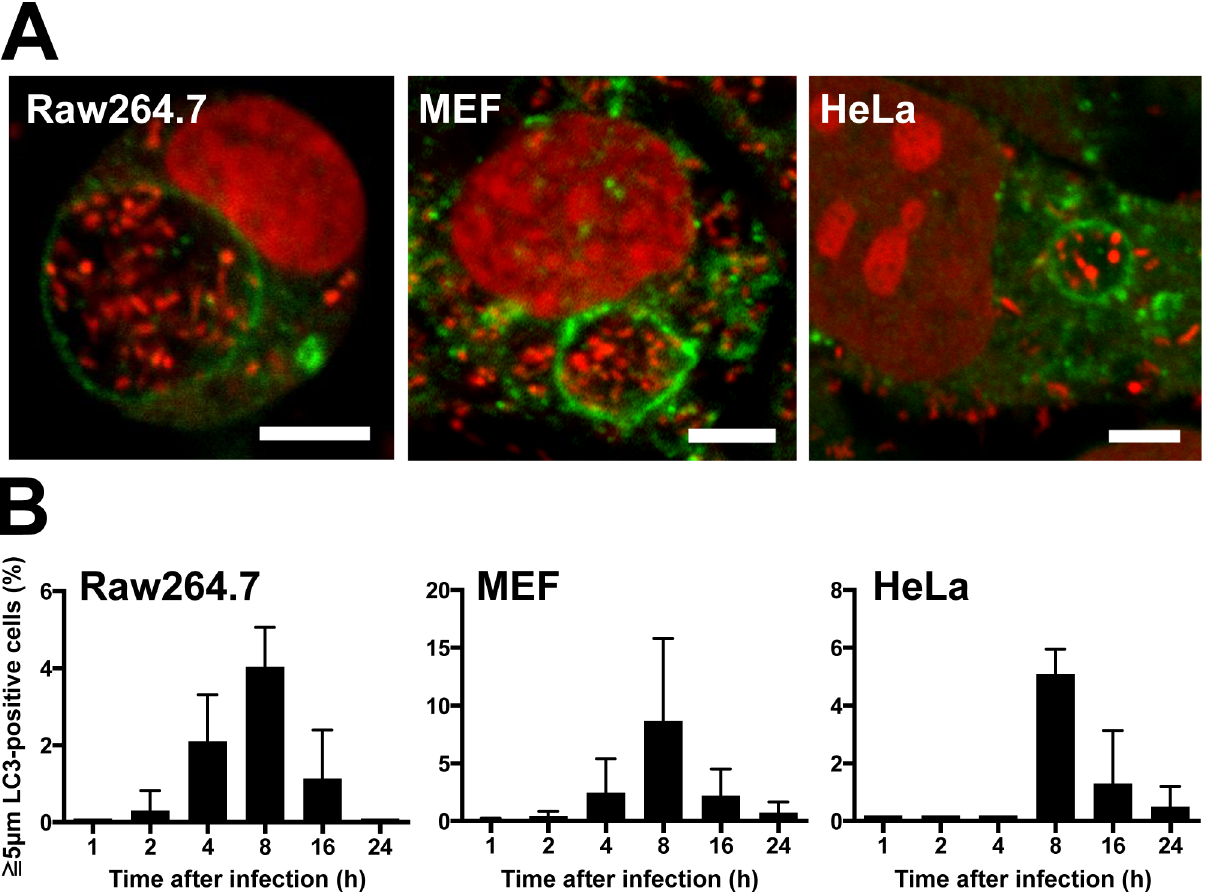
Fig 2. Large LC3-positive vacuoles containing many P . acnes . (A) Confocal microscopic image of large ( (cid:1) 5 μ m in diameter) LC3-positive vacuoles containing many P . acnes found in Raw264.7, MEF, and HeLa cells at 8 h MOI 1000 postinfection. Scale bar: 5 μ m. (B) Frequency of cells with large LC3-positive vacuoles containing P . acnes at 1, 2, 4, 8, 16, and 24 h MOI 1000 postinfection. Data are representative of at least three independent experiments. Black bars; means +